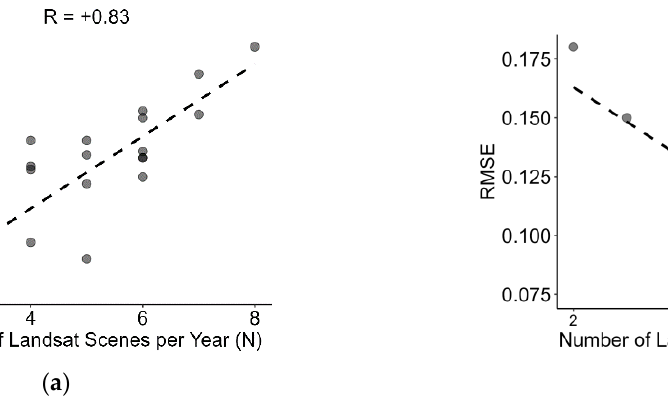
Figure 4. The correlation plots between the total number of Landsat scenes per year (N) and ( a ) R 2 values and ( b ) RMSE values obtained during the accuracy assessment of referenced and synthetic NDVI products from 2001 to 2019. The correlation coefficient refers to R (see Equation (5)).